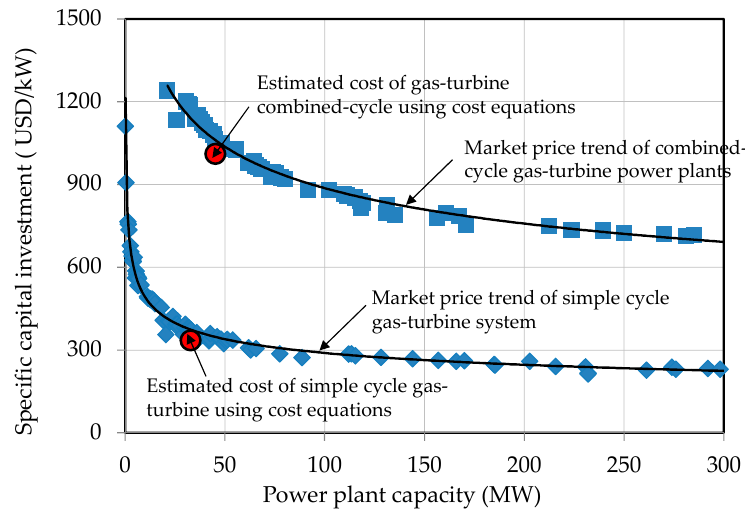
Figure 3. Comparison between the cost estimate and the current market price [8] of gas turbines.